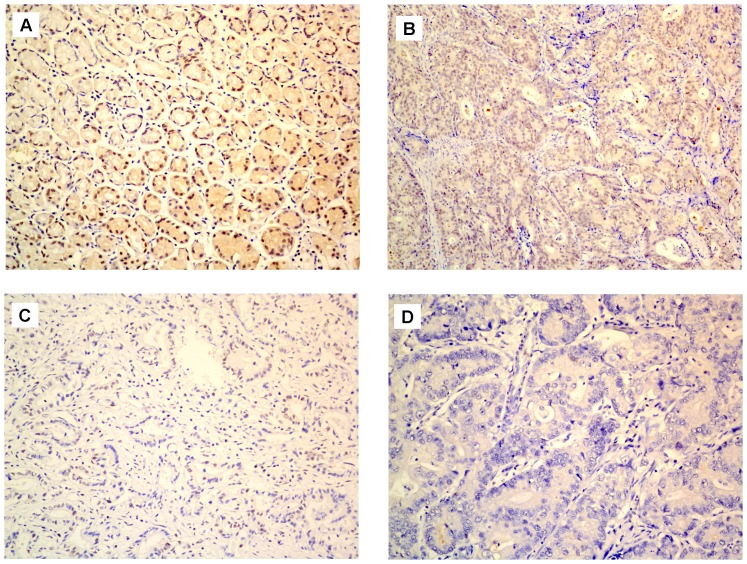
FOXO3a protein expression in gastric cancer and surrounding non-tumorous tissues detected by immunohistochemistry.(A) Normal gastric tissues distant from the tumor were scored as FOXO3a (+++); (B) Well differentiated gastric cancer was scored as FOXO3a (++); (C) Moderately differentiated gastric cancer was scored as FOXO3a (+); (D) Poorly differentiated gastric cancer was scored as FOXO3a (-). Original magnification: 200×.